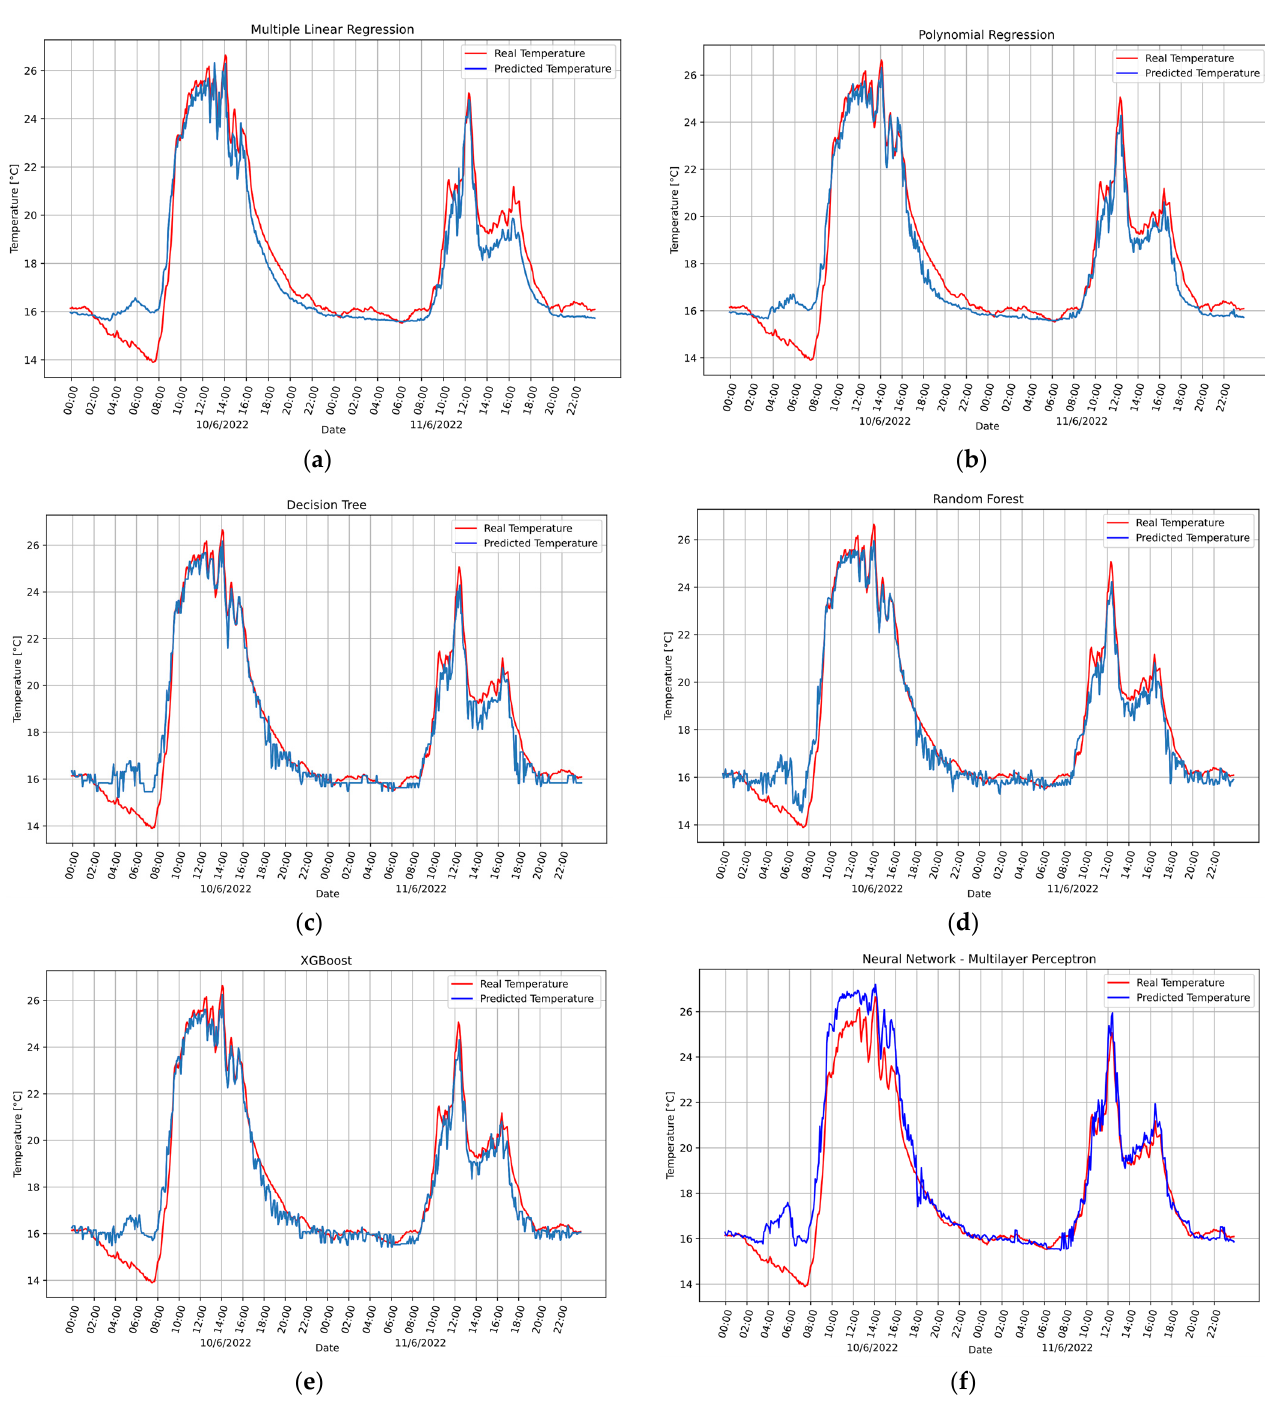
Figure 5. Temperature forecast techniques: ( a ) Multiple linear regression, ( b ) Polynomial regression, ( c ) Decision tree, ( d ) Random forest, ( e ) XGboost, ( f ) Multilayer perceptron neural network.